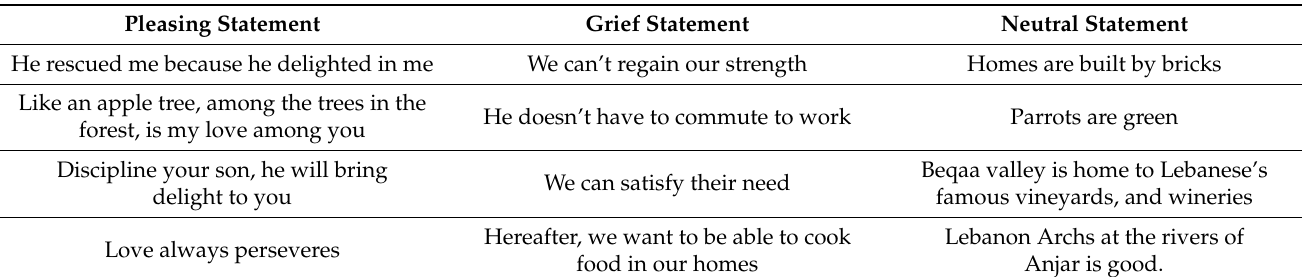
Table 2. Samples of statements for text-based stimulation according to the experimental